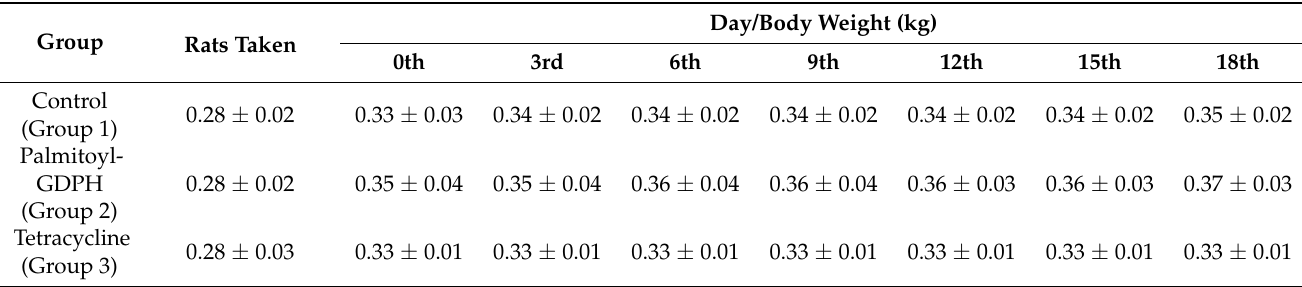
Table 3. Effects of treatment on body weight ( n =